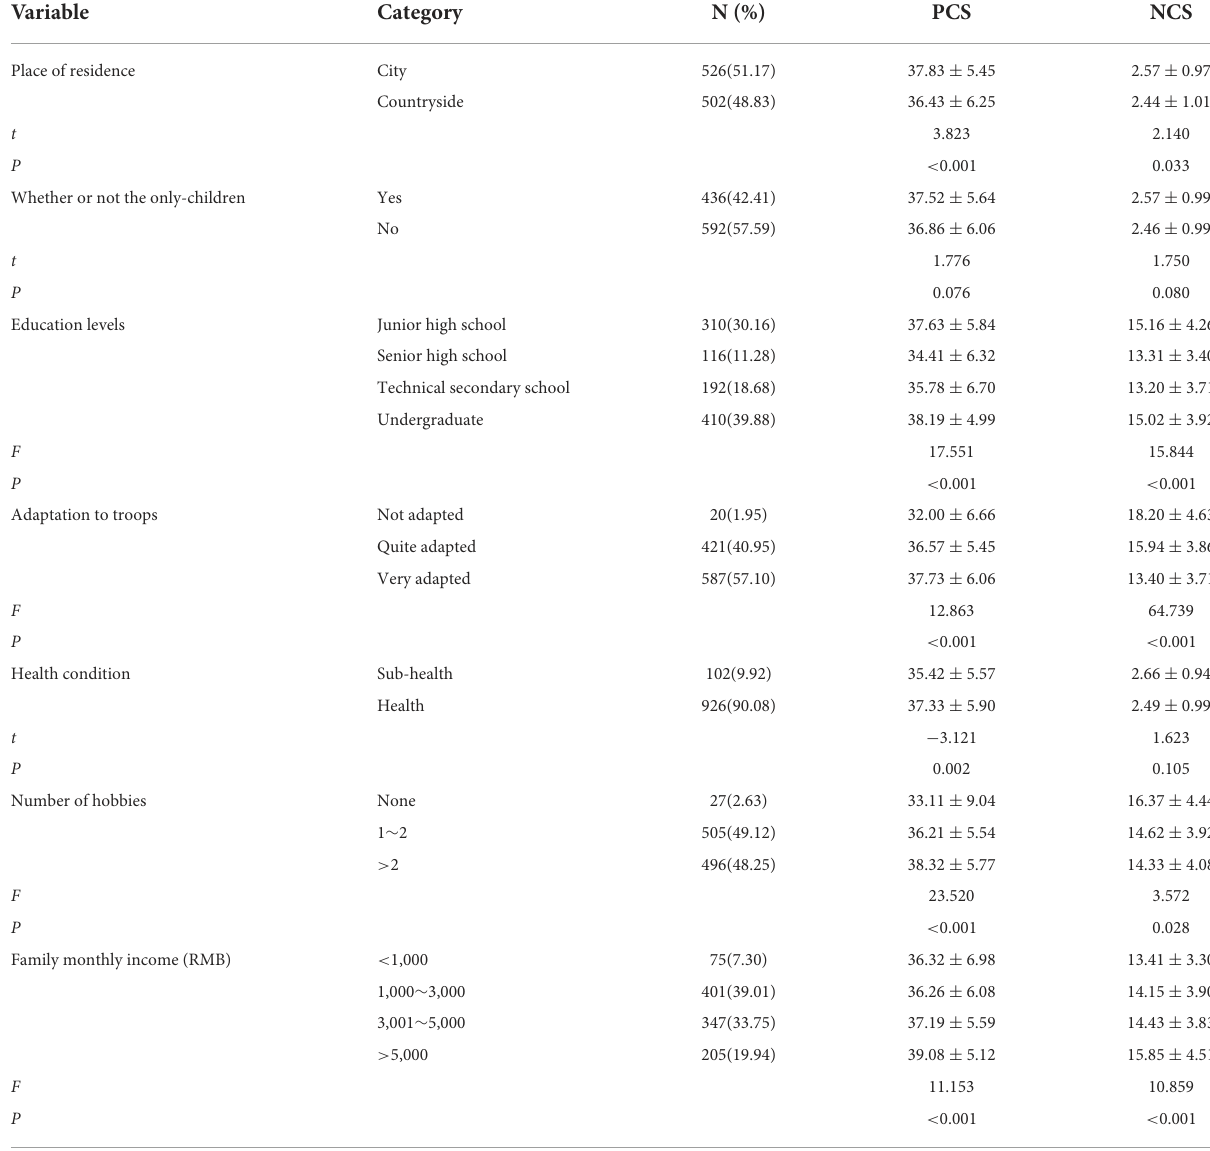
TABLE 1 Demographic characteristics of recruits and the comparison of coping styles ( N = 1,028).